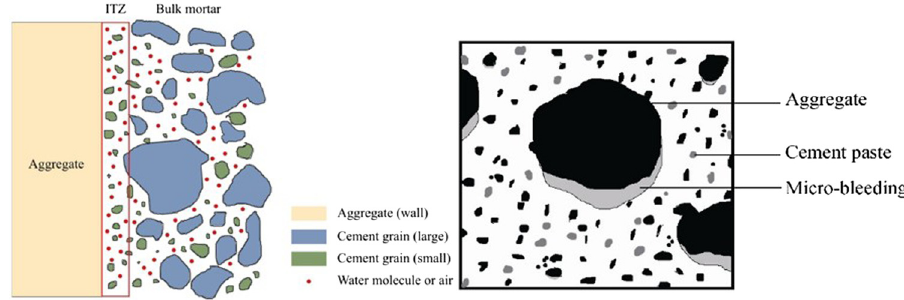
Figure 2: Illustration of the “ wall e ff ect ” and micro - bleeding e ff